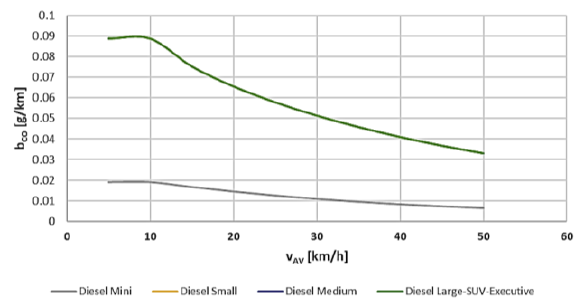
Fig. 34. CO emission from diesel oil PCs for vehicle segments depending on average speed